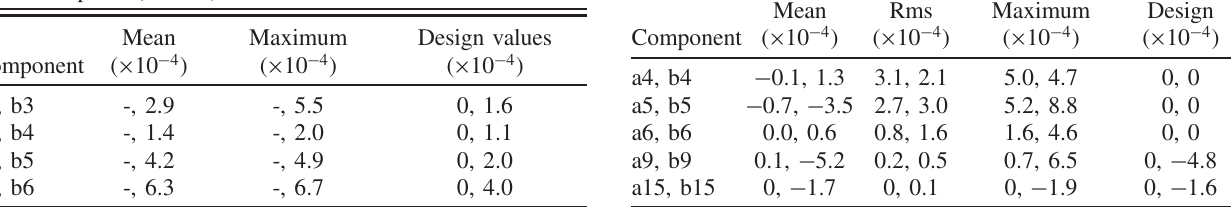
TABLE II. Magnetic measurement results for the DDBA gradient dipoles (1.4 kA).